Question: Express in one sentence what the figure is showing.
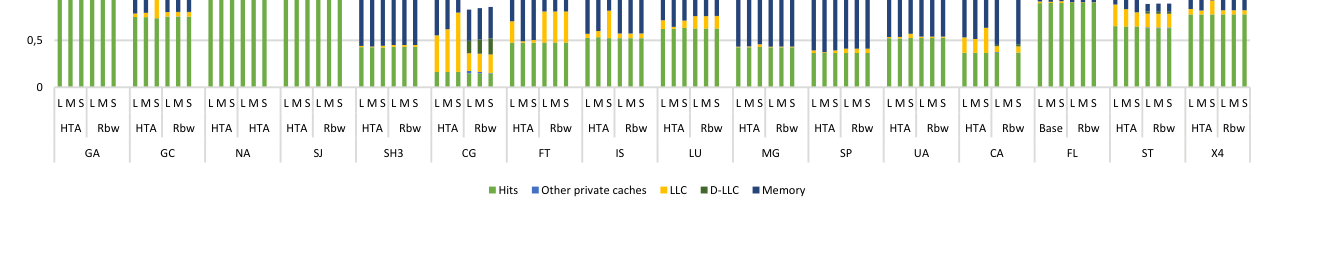
Answer: Large-size normalized memory latency in a 4-CMP system.(large: 131k; medium: 16k; small: 4k) and LLC (full:4MB per CMP, half: 2MB  per CMP) in a 4-CMP system.